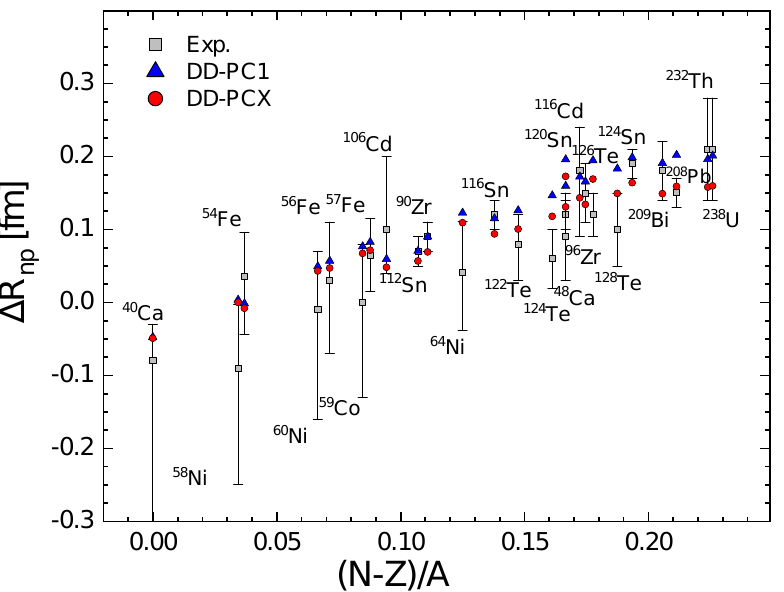
Figure 3. The neutron skin thickness as a function of the neutron excess for the DD-PC1 and DD- PCX functionals. The experimental data are taken from References [53,54] in which the proton distributions were obtained from electron scattering data for Sn nuclei [61] and from muonic atom data for others [62–64].